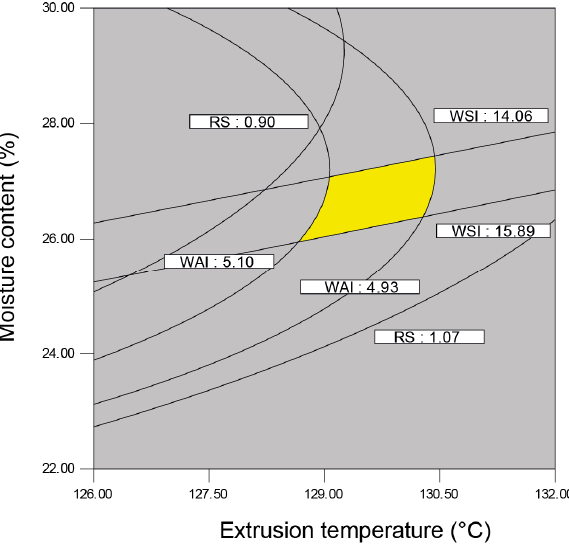
Figure 5. Optimized region obtained of contour plots of the physicochemical characteristics of the flours obtained by extrusion (WAI = water absorption index, WSI = water solubility index, RS = resistant starch).